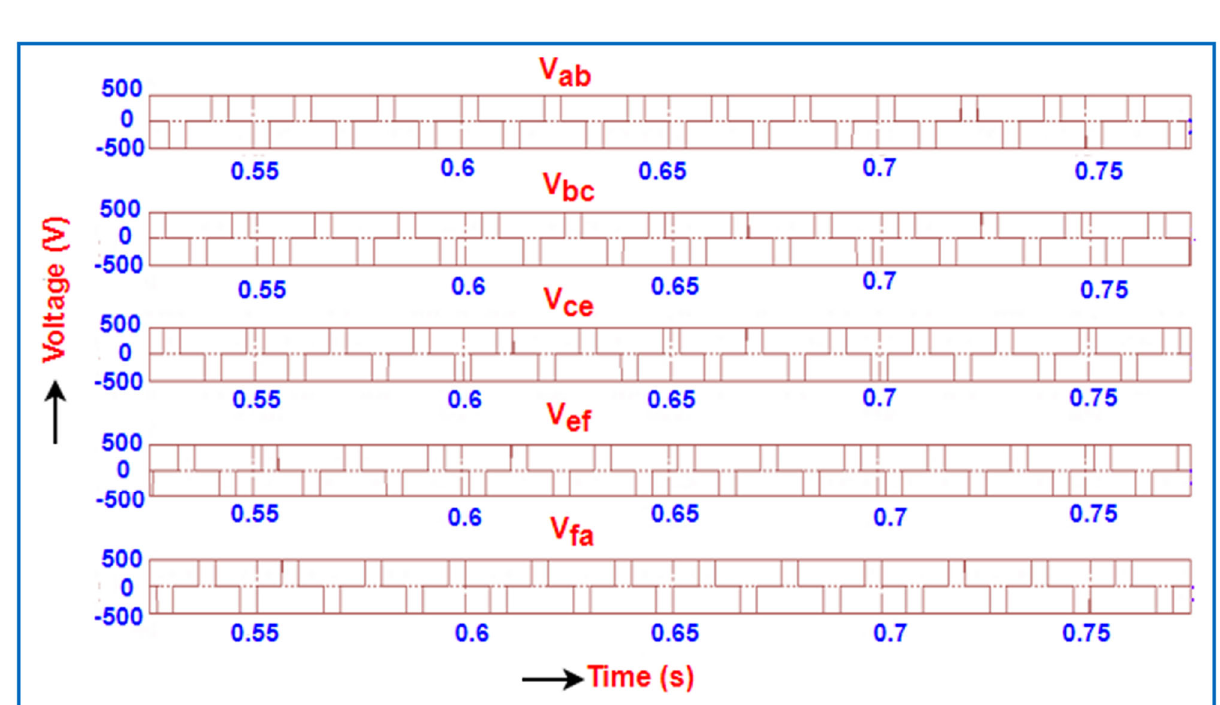
Figure 2. Five phase ‐ inverter—line voltage.